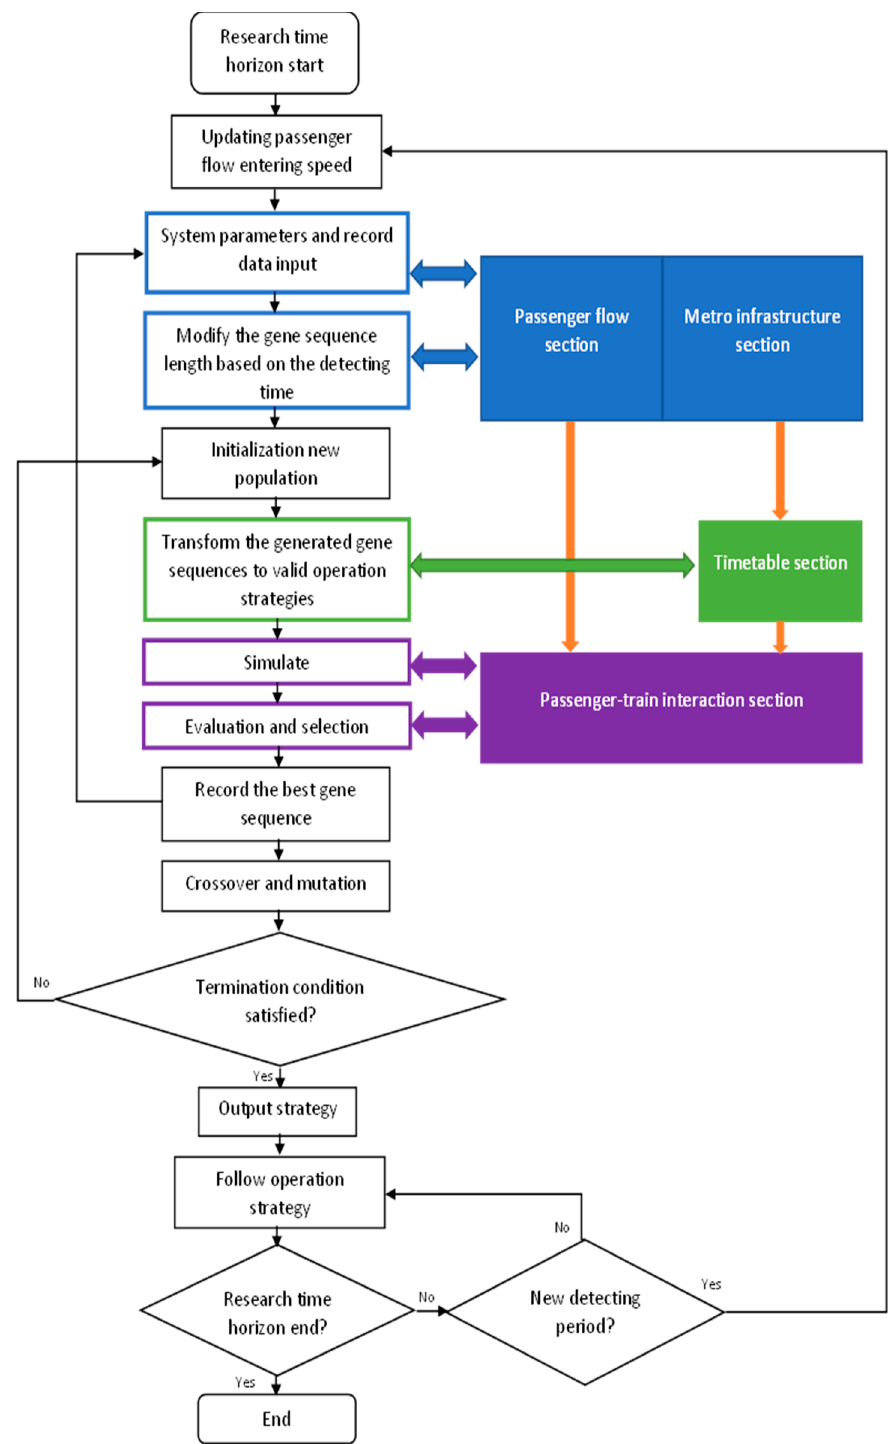
Figure 5. Flow chart of GA_RPOM in the optimisation process.